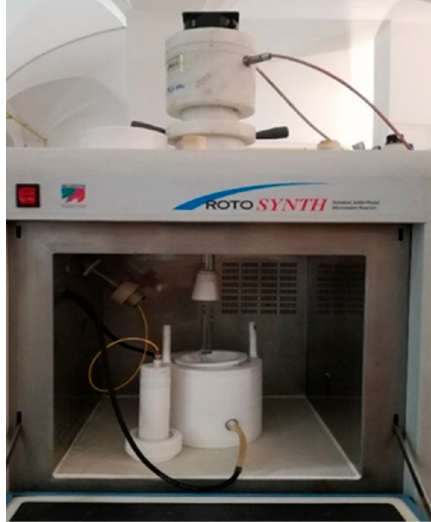
Figure 8. Combined MW/US device.